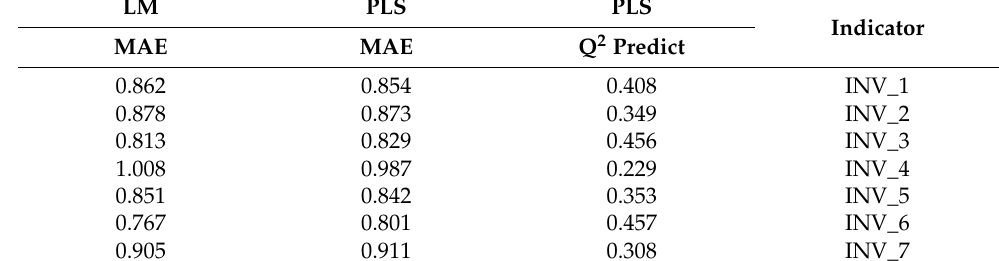
Table 7. Results of PLSpredict.